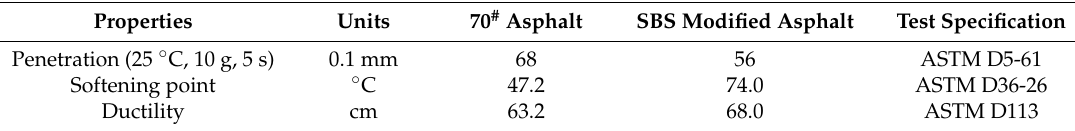
Table 1. Basic properties of 70 # asphalt and SBS modified